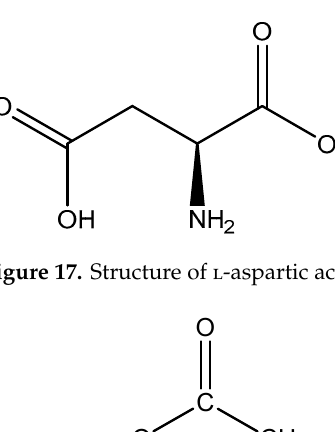
Figure 16. Structural Illustration of the magnesium bis (hydrogenmaleate) hexahydrate structure reported by Gupta et al. [103].